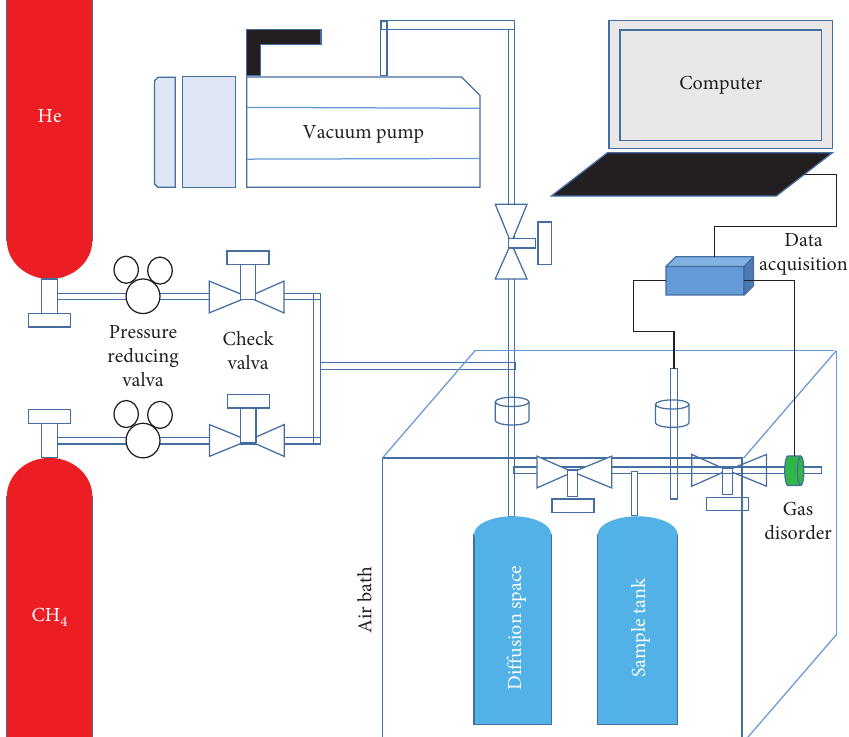
Figure 1: Schematic diagram of the experimental platform for the high-low temperature coal gas desorption and adsorption experiments.